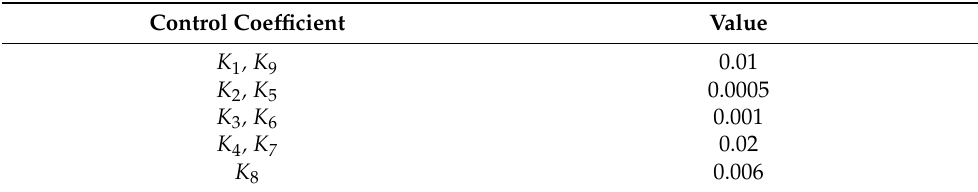
Table 2. The control coefficients of the controller in the